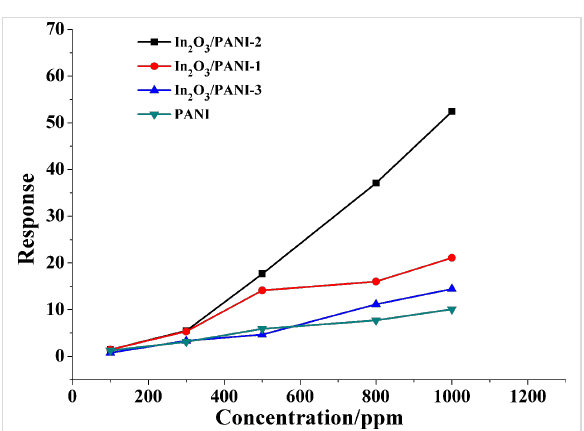
Figure 6: The response values of pure PANI and three In 2 O 3 / PANI nanofibers sensors to different concentration of NH 3 at room tempera- ture.